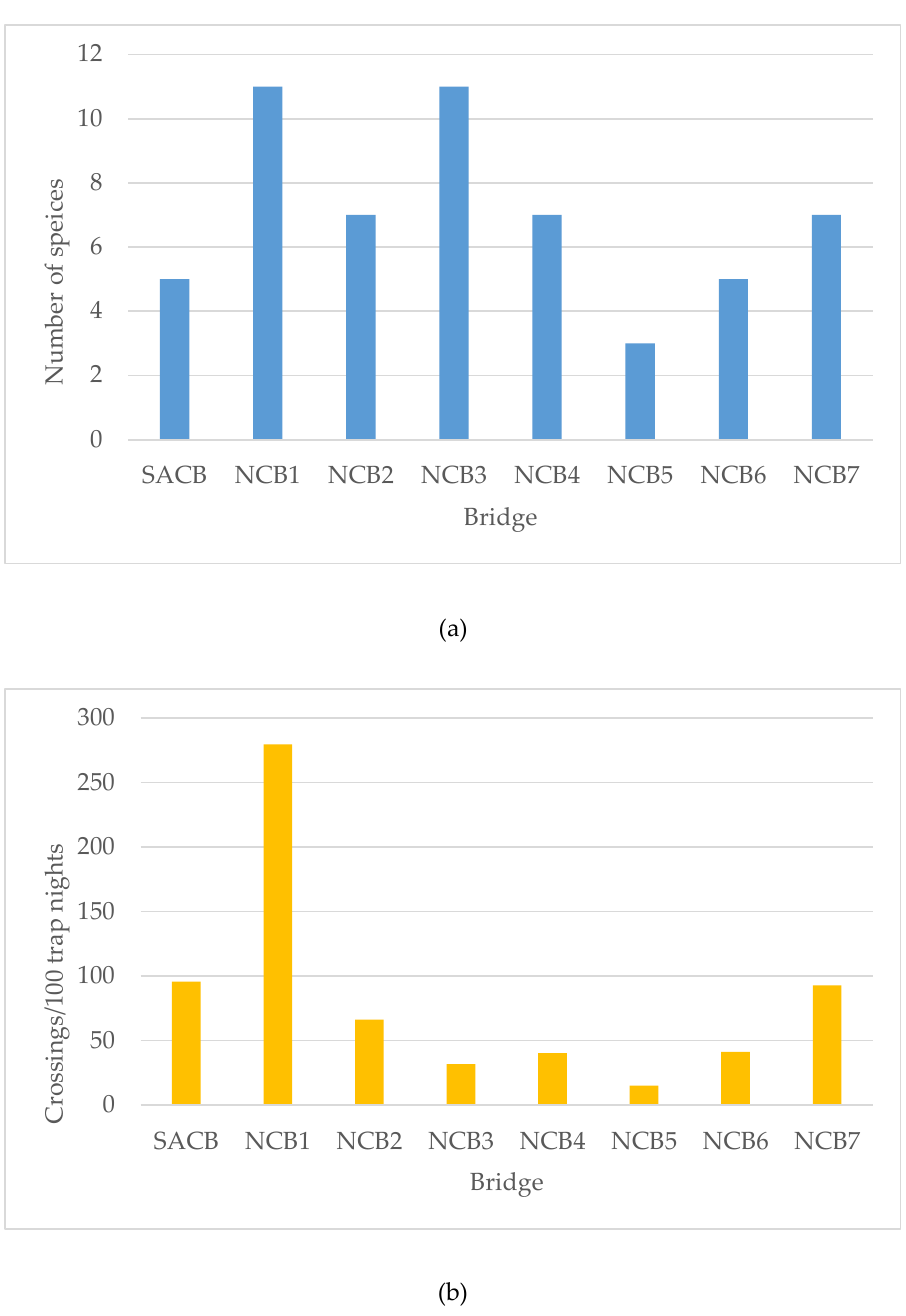
Figure 4. ( a ) The number of species and ( b ) the crossing rates in the SACB and the NCBs over the course of the